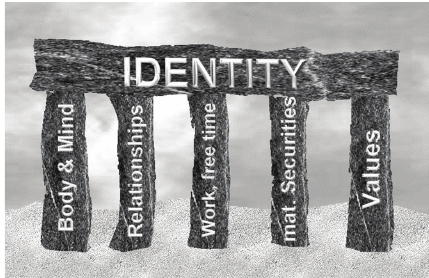
Figure 1: Five pillars of identity by Petzold (own drawing).